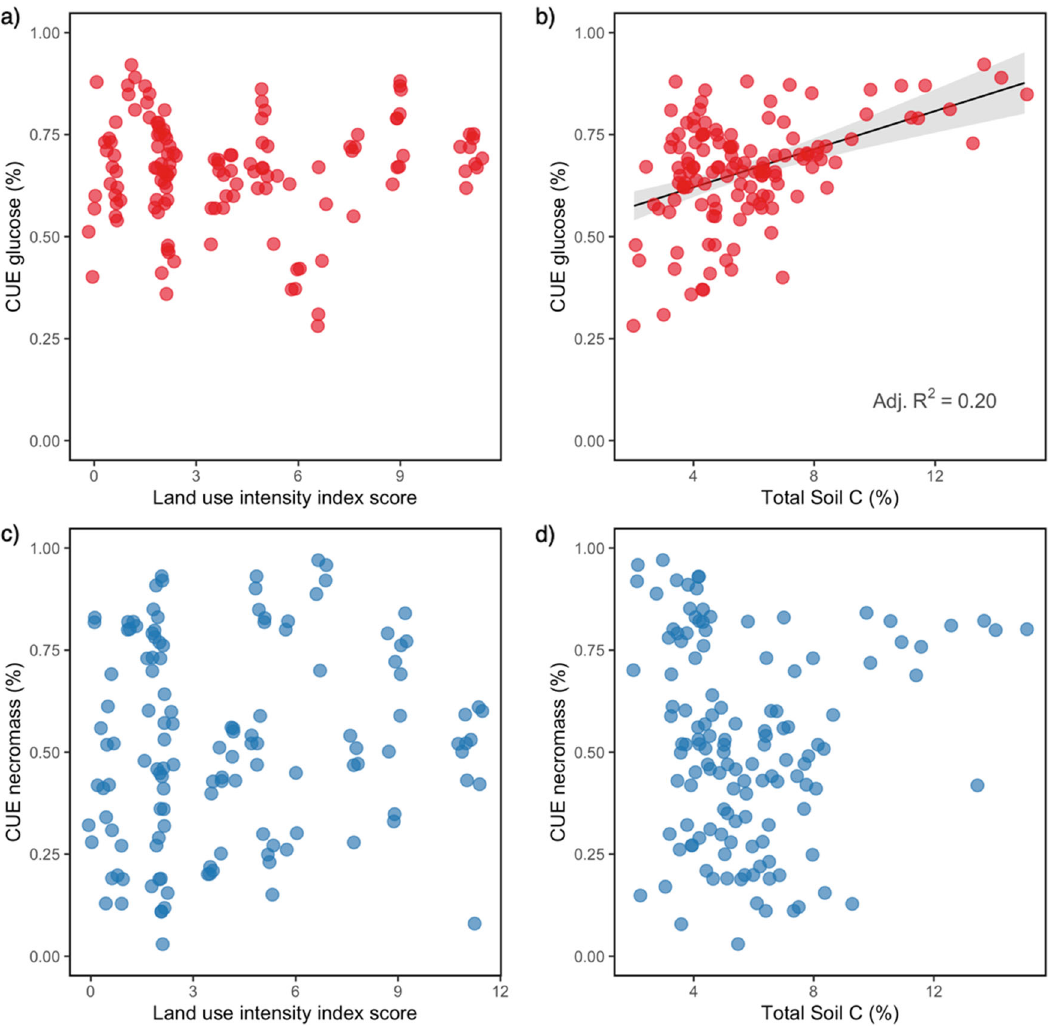
Fig. 3 The response of microbial CUE to land use intensity and soil carbon. Microbial CUE-glucose ( a , b , red) and CUE-necromass ( c , d , blue) and their relationship with land use intensity index score ( a , c ) and soil total carbon (%) in the top 15 cm ( b , d ). Microbial CUE of both substrates does not vary with index score, or with total soil C for necromass-CUE ( P > 0.05, n = 135). There is a positive relationship between CUE-glucose and total soil C ( P <